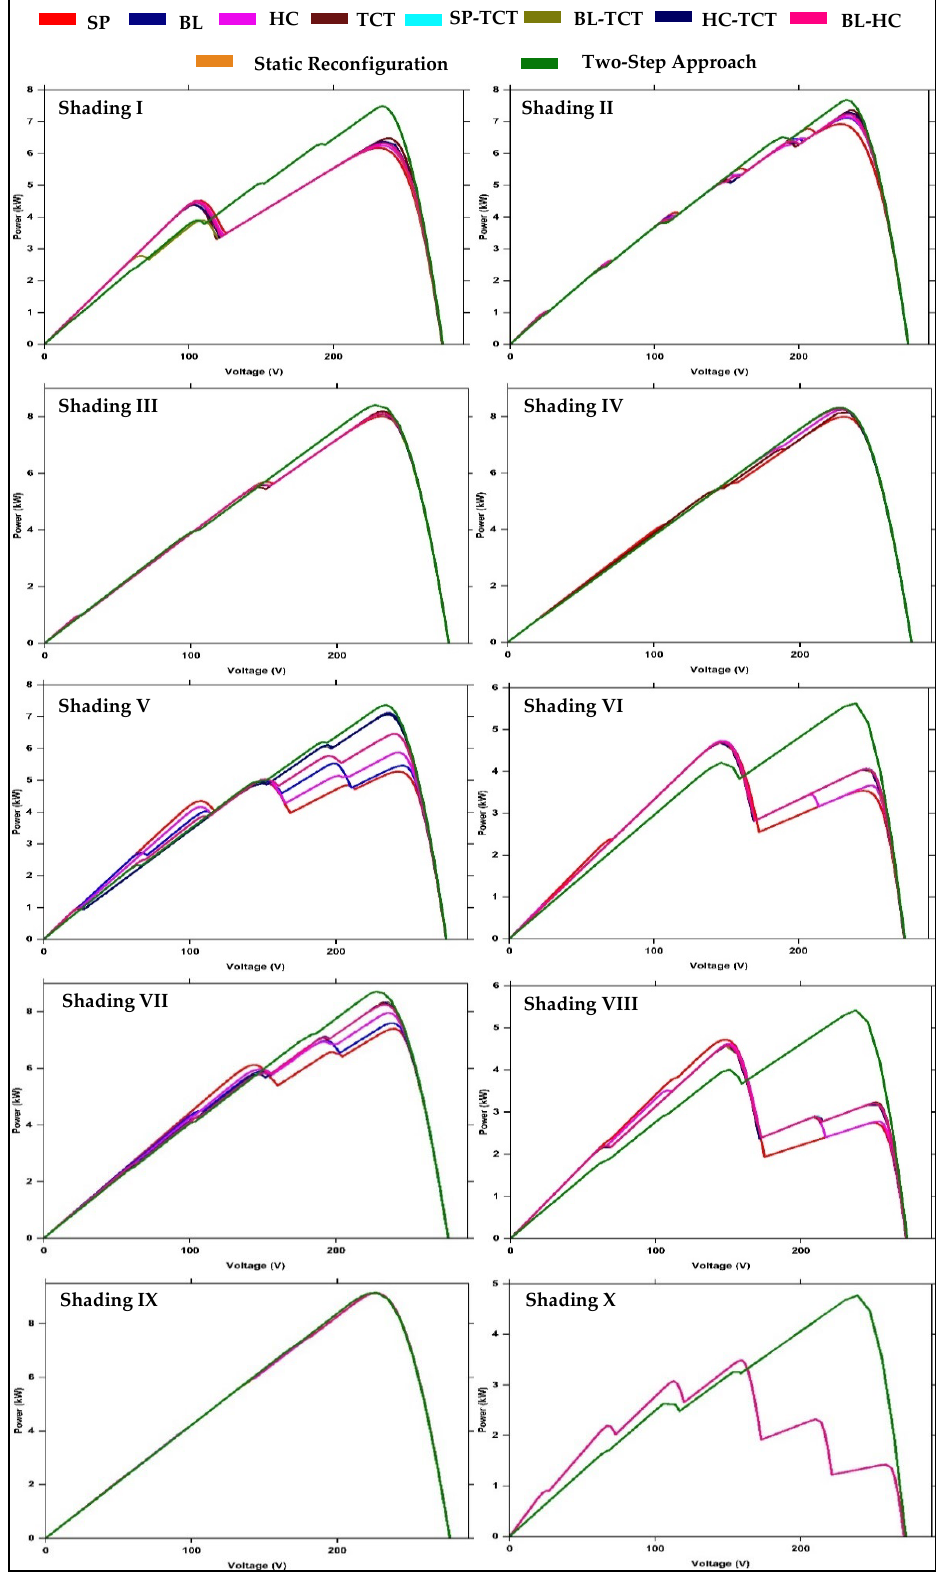
Figure 17. P~V curves of the array configurations under different random partial shading cases.